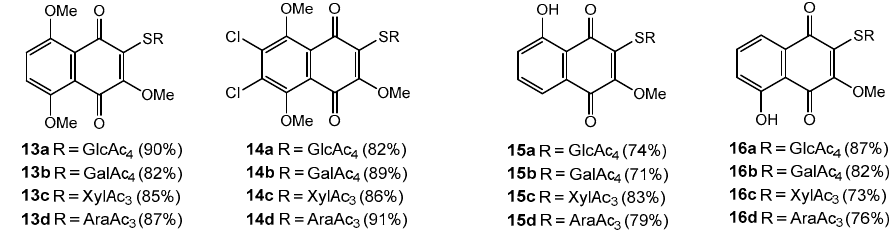
Figure 2. Acetylated thioglycosides of substituted methoxy-1,4-naphthoquinones.